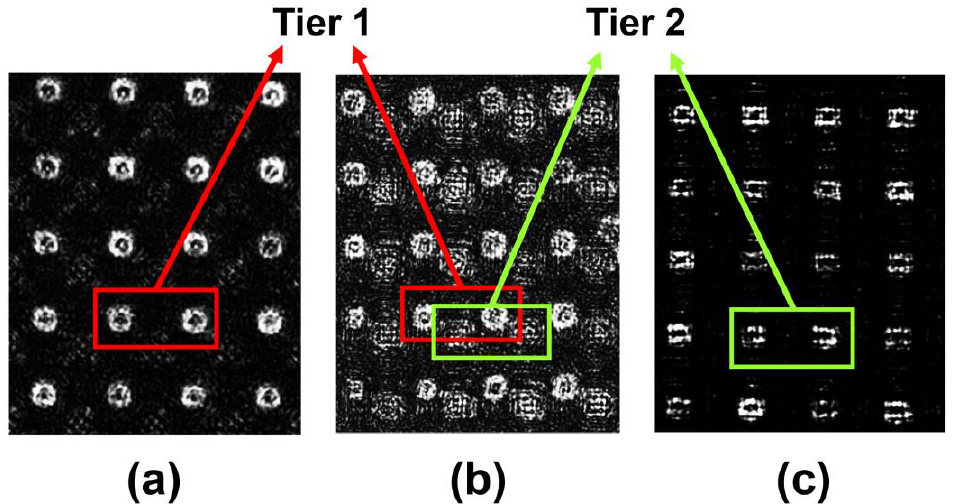
Figure 6. Images of the dual-tier MPA illuminated by incident polarized light at different incident angles. ( a ) 0 degrees. ( b ) 22.5 degrees. ( c ) 45 degrees.